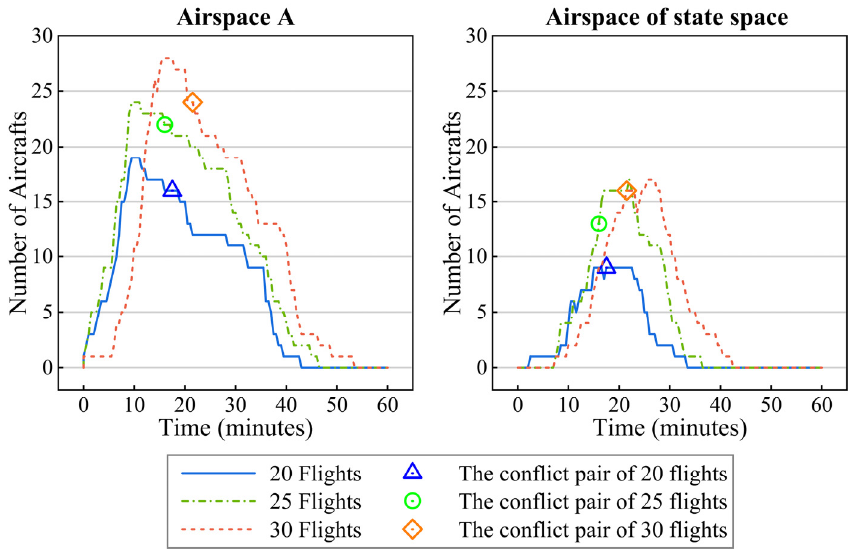
Figure 9. Number of aircraft in the two airspaces changing with